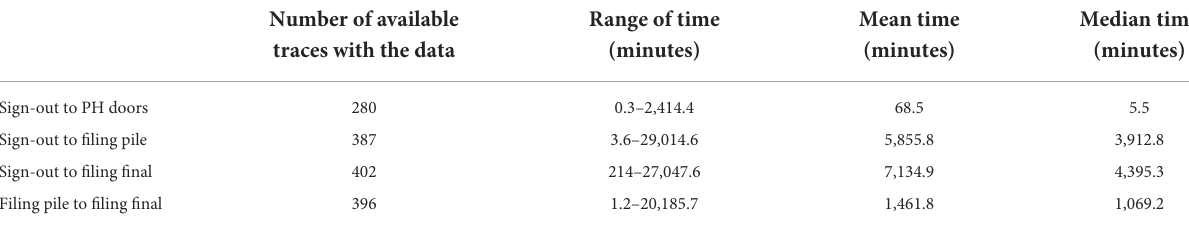
TABLE 1 Time taken between specified workflow points in the analog